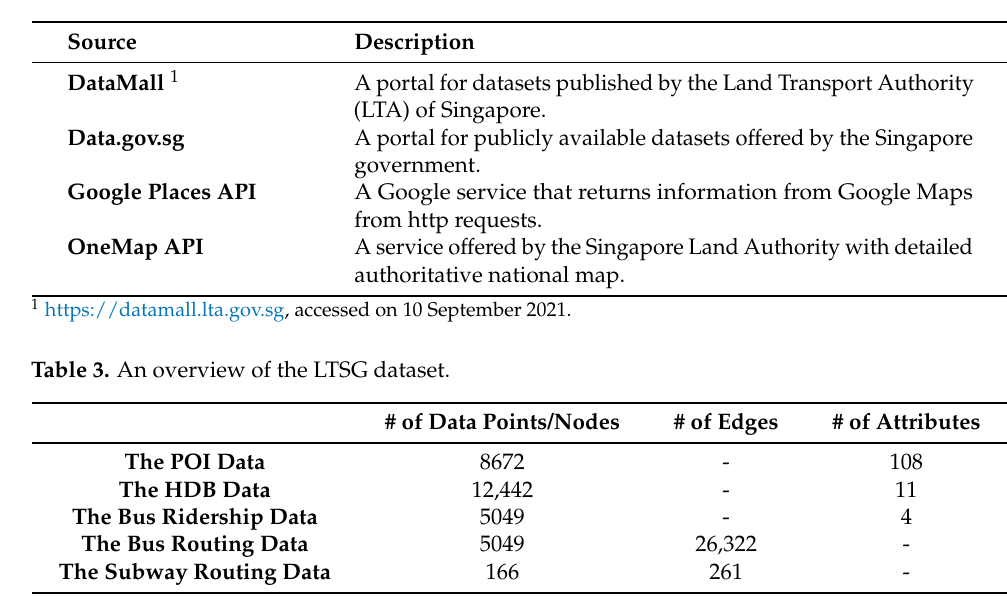
Table 2. List of data sources.